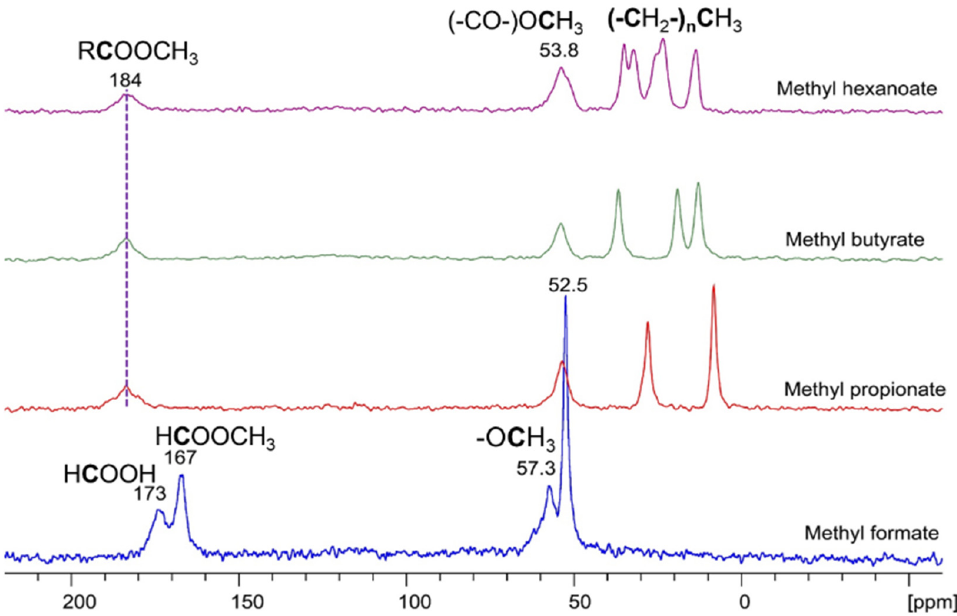
Figure 10. 13 C CP/MAS NMR spectra of different methyl esters adsorbed on H-ZSM-5 SAR23.